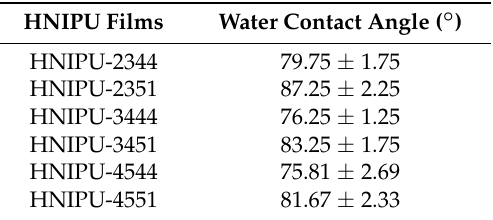
Table 3. The water contact angle of different HNIPUs films.